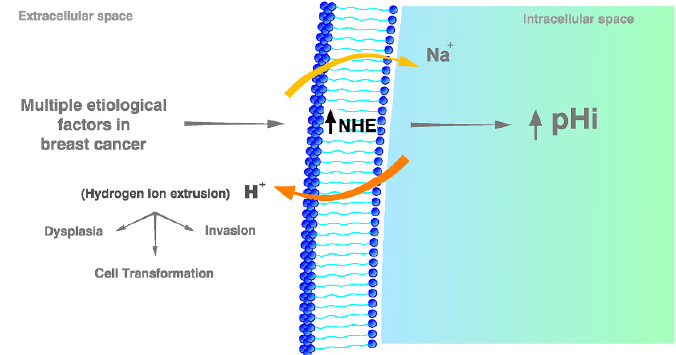
Figure 2. H + -extrusion in the etiology of breast cancer. Multiple etiological factors of di ff erent natures and origins are carcinogenic in breast cancer due to their positive regulation of NHE1 and / or intracellular alkalosis and / or extrusion of H + . This mechanism induces cell transformation and invasion (for further details, see